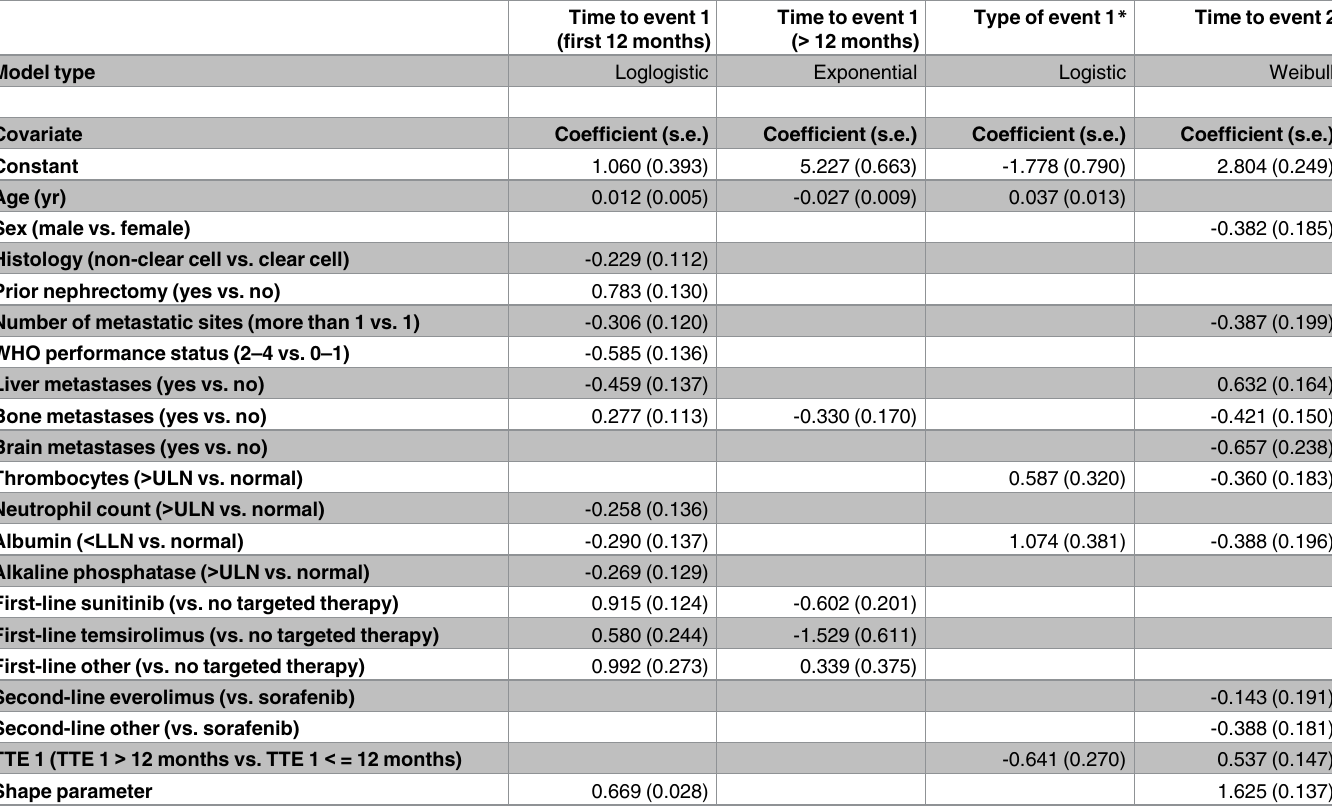
Table 2. Covariatesand corresponding coefficients of the survival models and logistic regression